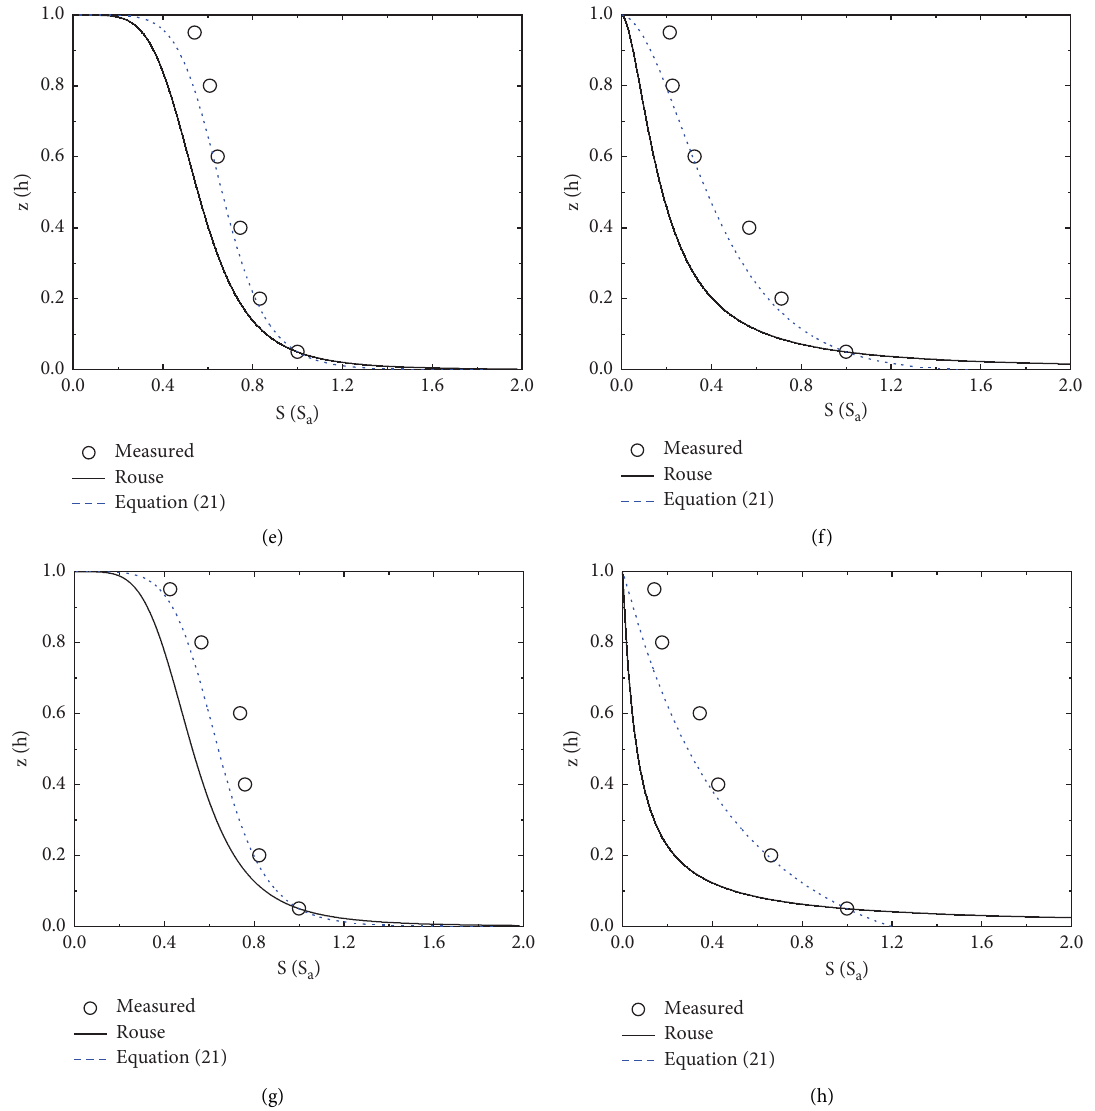
Figure 7: Calculation-suspended sediment profles calculated by diferent